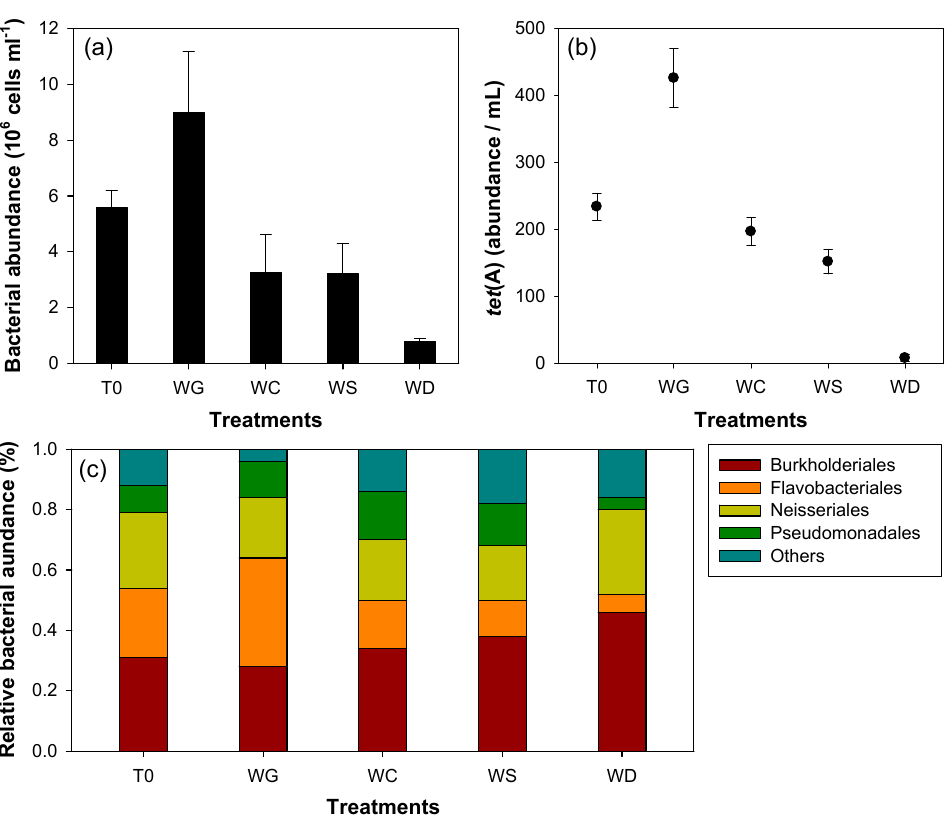
Figure 1. Bacterial abundance and tet (A) gene in water samples prior to treatment (T0) and in the four experiment groups (WG, WC, WS, and WD) after 3 days: ( a ) bacterial abundance; ( b ) tet (A) abundance per mL; and ( c ) the relative bacterial abundance (%). WG, without gazing by cladocerans; WC, water of the Chydorus sphaericus -enriched treatment; WS, water of the Simocephalus vetulus -enriched treatment; WD, water of the Daphnia obtusa -enriched treatment.